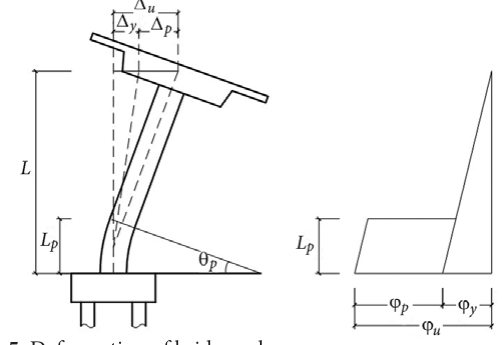
Fig. 5. Deformation of bridge columns